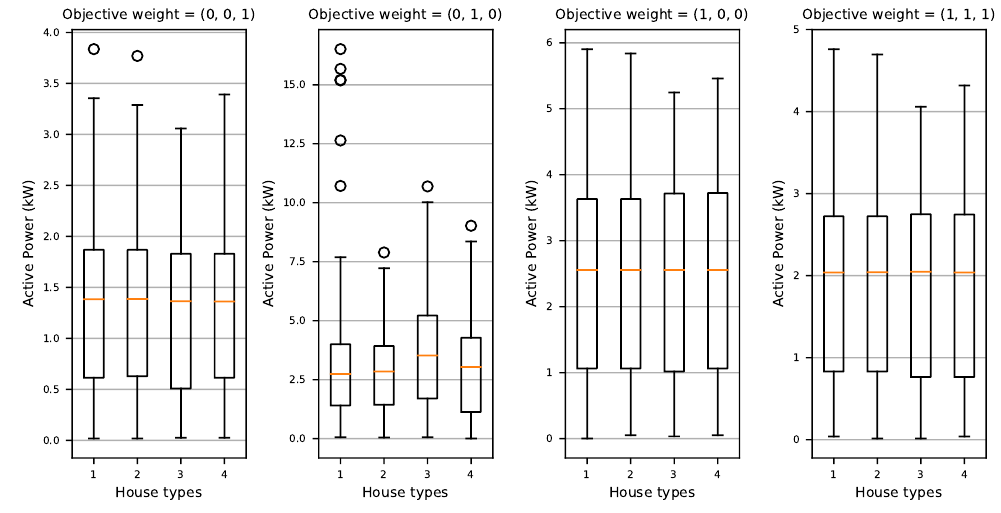
Figure 10. Schematic of Three-Phase HEMS.